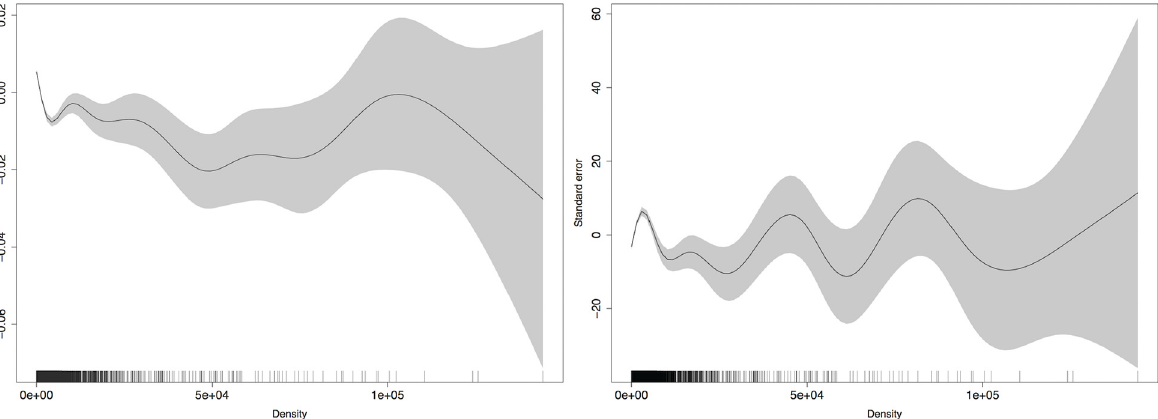
Fig 6. GAM predictions — Density vs. Deviation from the mean Peak Load (Proportion of Infectious) on the left and mean Peak Load (Actual) on the